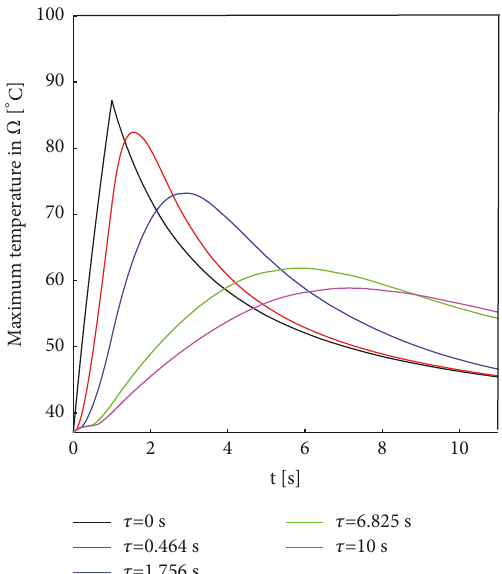
Figure 2: Maximum temperature in space 𝑟, 𝑧 ∈ Ω versus time with different thermal relaxation time for 𝑝 0 = 1.5 × 10 5 𝑝𝑎 , 𝑟 0 = 1 𝑚𝑚 , 𝑑 = 1.5 𝑚𝑚 , 𝑢 = 5𝑐𝑚/𝑠 , 𝑓 = 1 𝐻𝑧 , 𝑓𝑎𝑐 = 0.5 , 𝑡 = 1𝑠 . Figure 3: Thermal lesion region in space 𝑟, 𝑧 ∈ Ω with different 𝑎 V 𝑒 𝑝 ℎ thermalrelaxationtimefor 𝑝 0 = 1.5×10 5 𝑝𝑎 , 𝑟 0 = 1𝑚𝑚 , 𝑑 = 1.5 𝑚𝑚 , 𝑢 = 5 𝑐𝑚/𝑠 , 𝑓 = 1 𝐻𝑧 , 𝑓𝑎𝑐 = 0.5 , 𝑡 = 1 𝑠 . 𝑎 V 𝑒 𝑝 ℎ